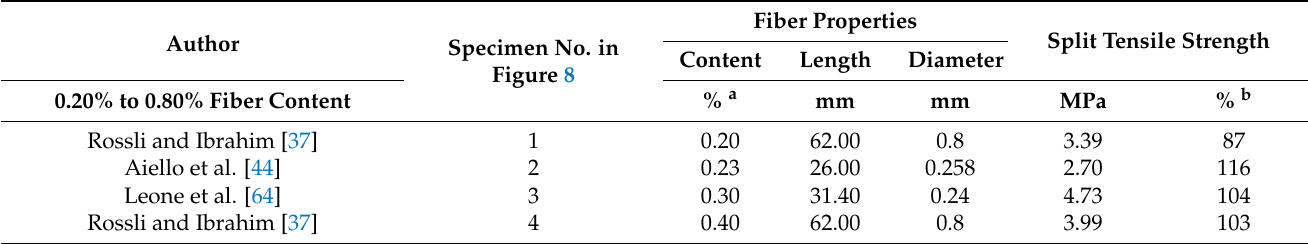
Table 6. Results of split tensile strength’s percent comparison and fiber properties of the concrete incorporating RSF by its volume fraction. Fiber Properties Split Tensile Strength Content Length